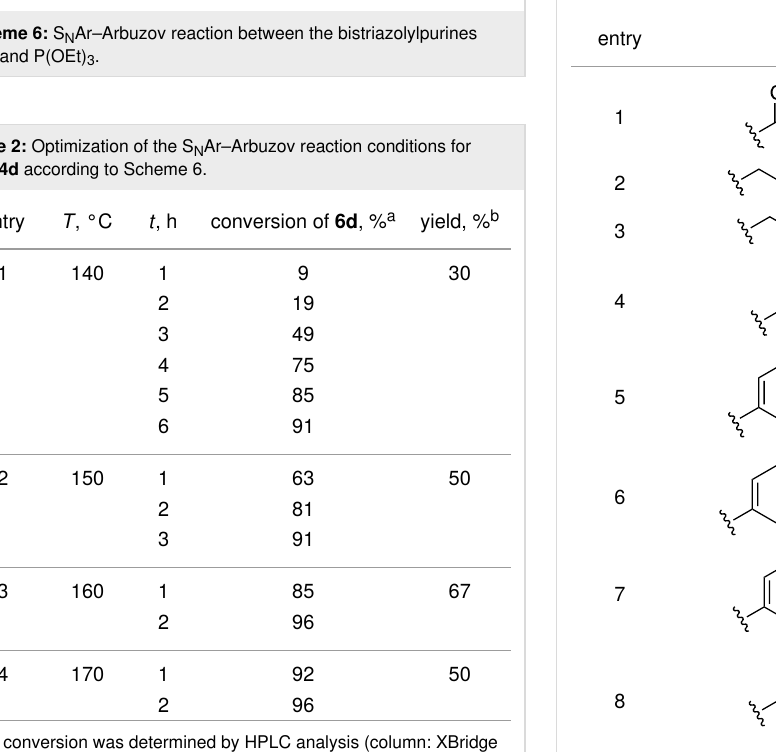
Table 3: S N Ar–Arbuzov reactions between 2,6-bistriazolylpurines 6a – i and P(OEt) 3 according to Scheme